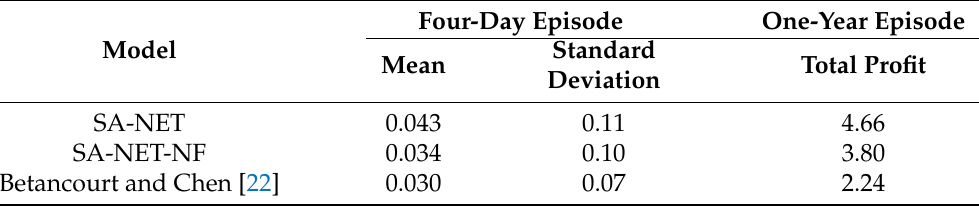
Table 4. Comparison of the performance of the algorithms in a short and long trading episode.